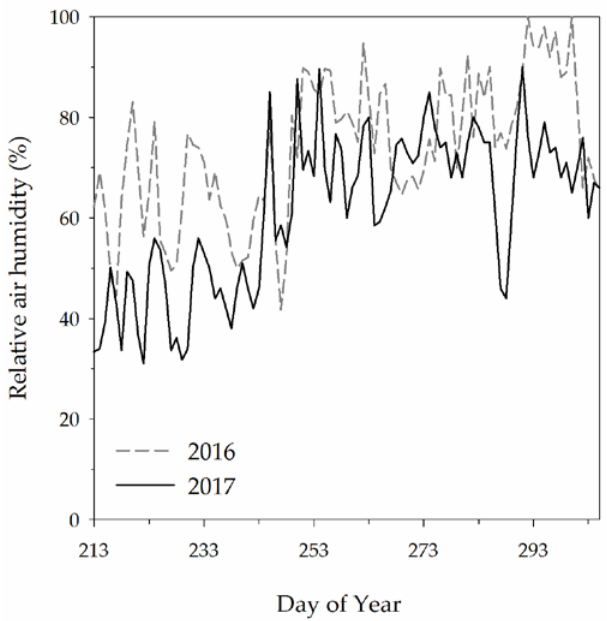
Figure 2. Seasonal pattern of daily mean relative air humidity recorded between 1 August and 30 October in 2016 and 2017.